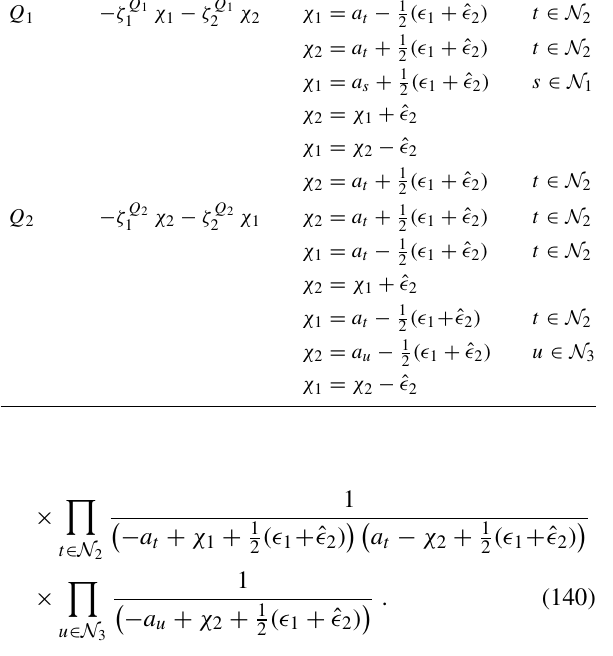
Table8 Welistthepolesthatcontributetothe q 1 q 2 termofthesuperpo- tential for the quivers Q 1 and Q 2 . In the second column we have shown only the parts of the JK vector that are relevant for this two-instanton contribution Quiver JK vector Poles χ − ζ Q 1 χ Q 1 − ζ Q 1 1 1 2